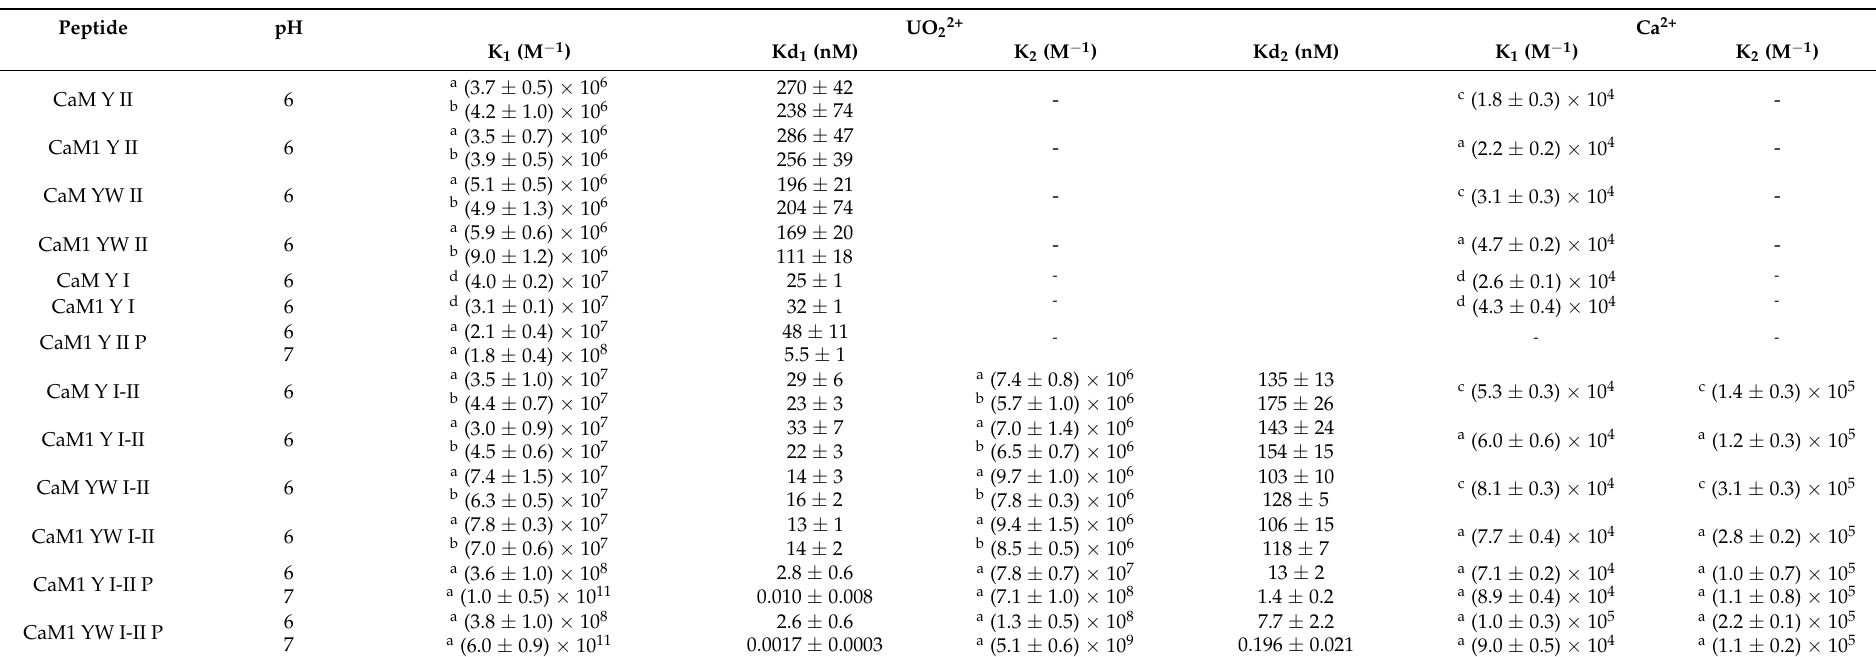
Table 2. Macroscopic binding constants for reaction of UO 22+ and Ca 2+ ions with the investigated mutants of CaM N-terminal domain. I = 0.12 M (MES, KCl); T = 298 K. All reported data are averages of three experimental